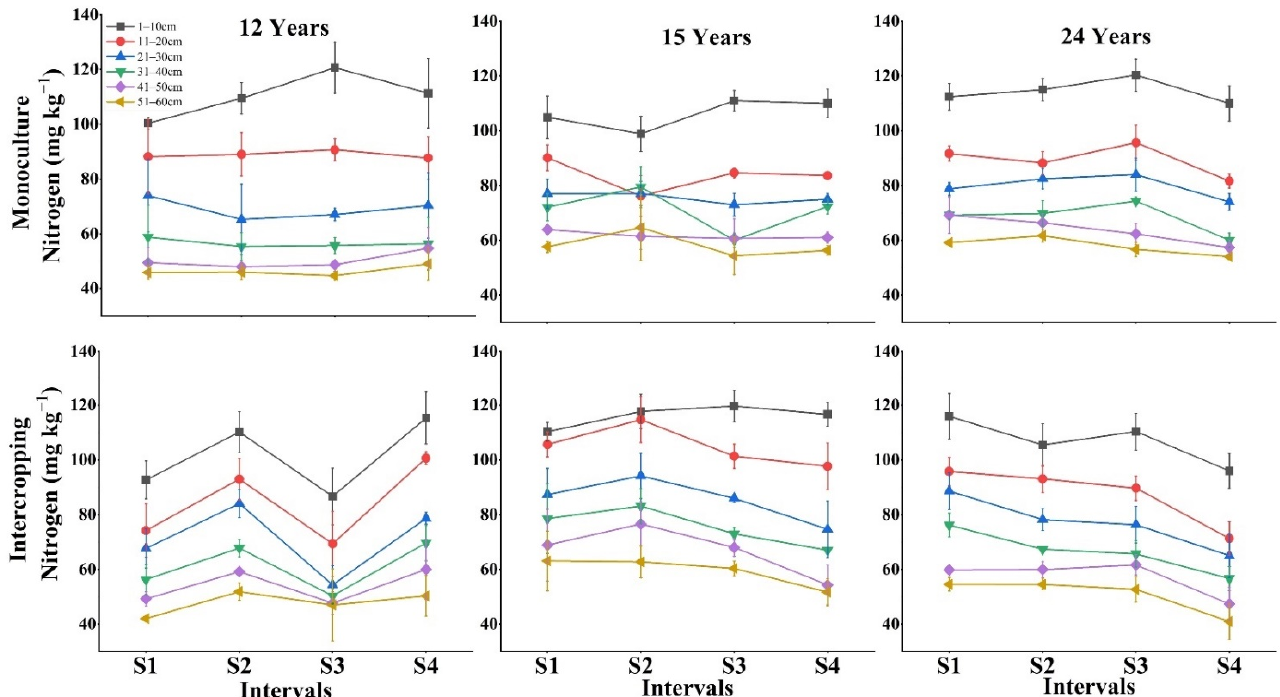
Figure 2. Soil available N in different soil layers across four sampling intervals (S1, June 2018; S2, September 2018; S3, December 2018; S4, March 2019) within different-aged stands of two plantation management types (rubber monoculture versus rubber–F. macrophylla intercropping).